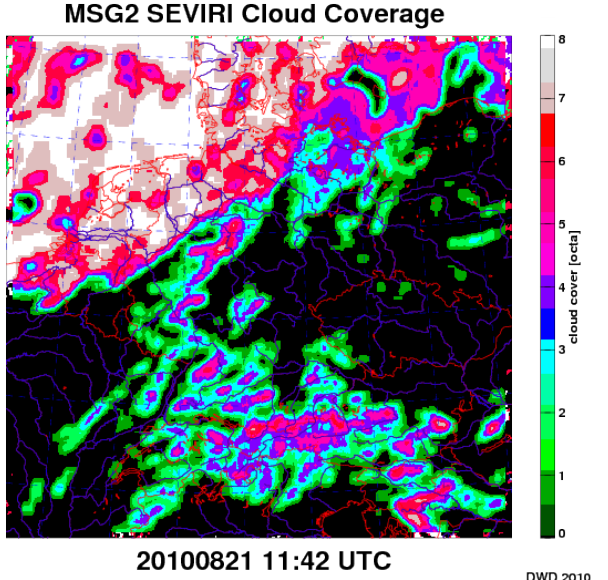
Figure 4: Timeserie of calculated and measured shortwave downward radiation for the pyranometer site Arkona, located at the coast of the Baltic Sea. Bad weather periods cause data gaps, like in August and November/December 2010 and August 2011 as well